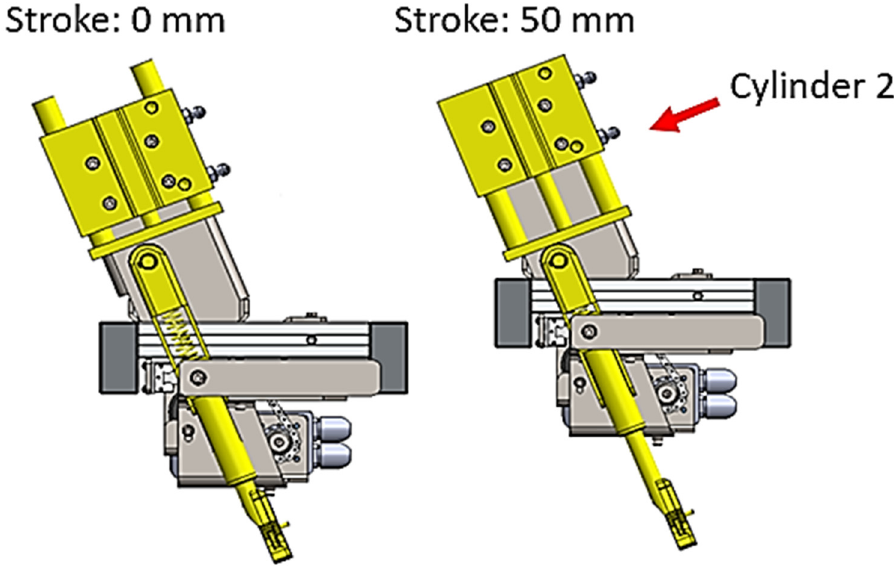
Figure 15. Linear movement of the yarn arm sub-assembly and its dependence.